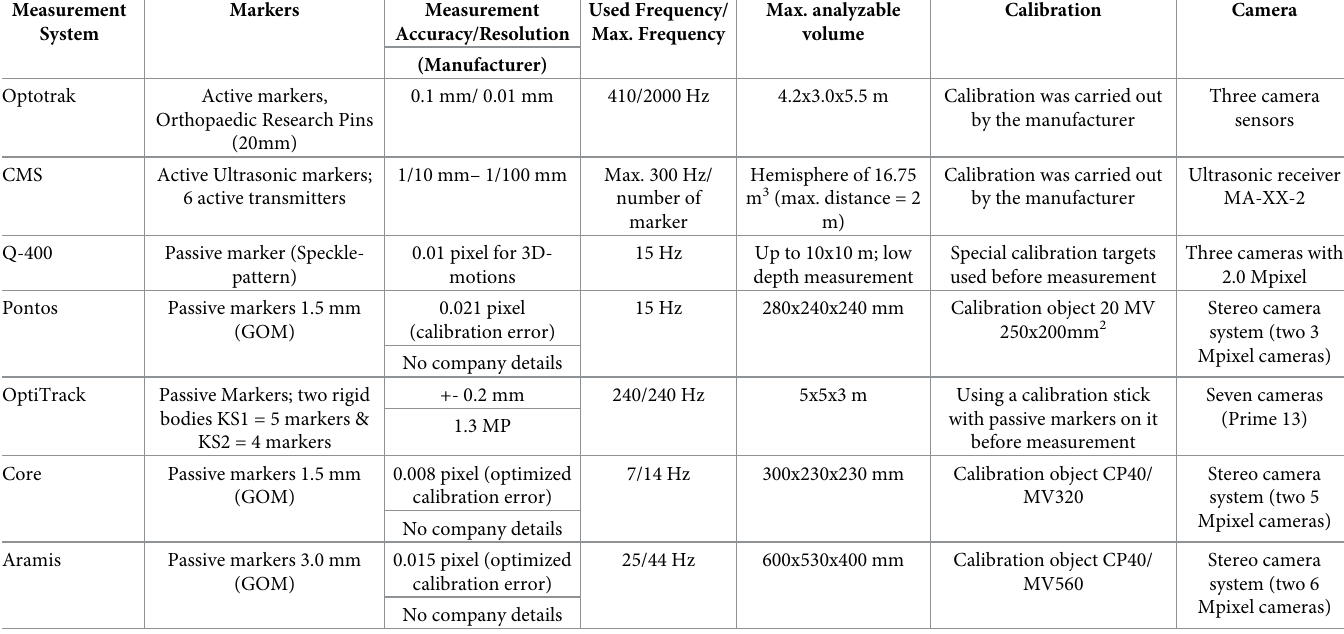
Table 1. Specifications of the seven measurement